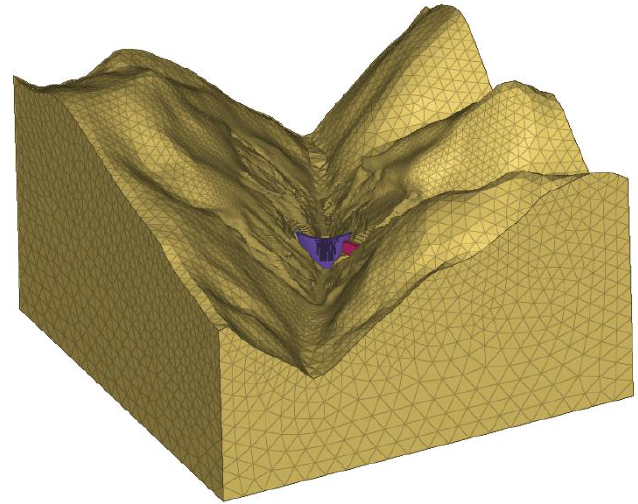
Figure 6. Finite element model of the Jinping I super-high arch dam.